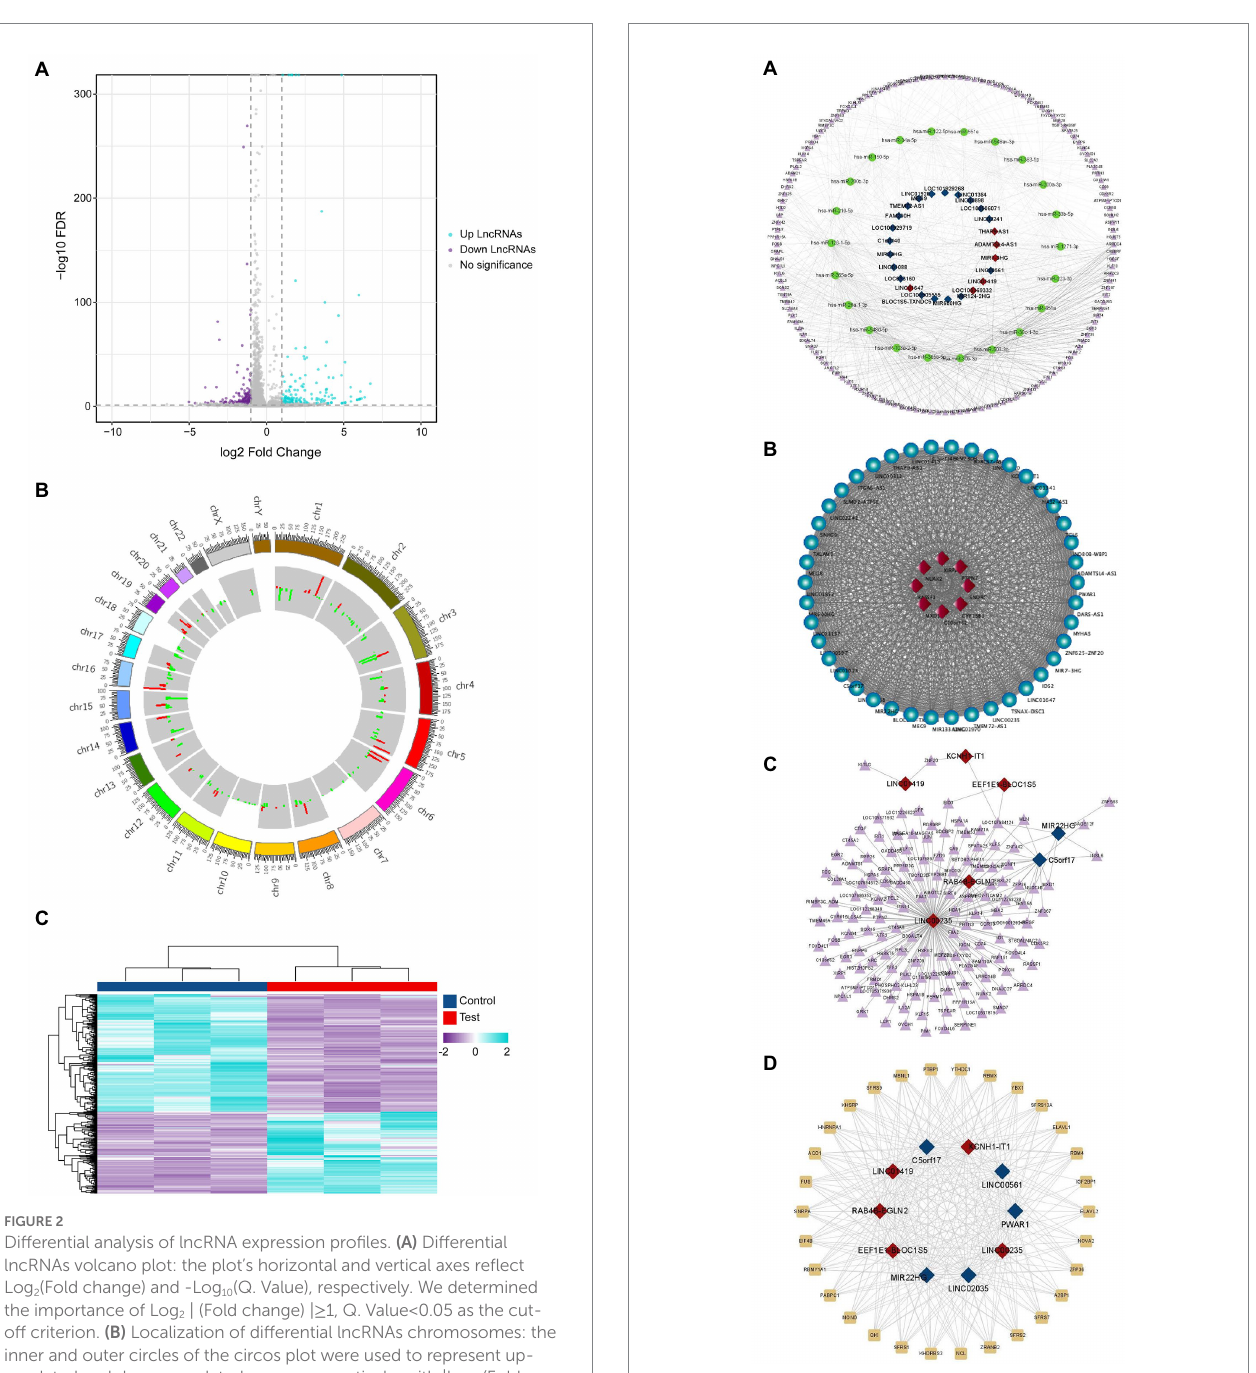
FIGURE 3 Prediction of differential lncRNAs regulation. (A) Differential regulatory network for ceRNAs centered on lncRNAs: This diagram depicts lncRNAs, miRNAs, and mRNAs as squares, circles, and triangles, respectively. Red and dark blue denote the up- and down-regulated lncRNAs, respectively. (B) The co-expression network of lncRNAs and protein-coding genes is constructed in Cytoscape by employing Pearson correlation coefficients. The dots and diamonds indicate lncRNA and mRNA, respectively. (C) Triangles and squares, representing mRNAs and lncRNAs, respectively, depict anticipated up- and down-regulated differential fold top five lncRNAs and targeting relationships of all differential mRNAs, along with all reciprocal pairs predicted to have targeting associations. (D) Network regulation of interactions between lncRNAs and RNA-binding proteins: all potential target proteins of the top five predicted up- and down- regulated differential fold lncRNAs, and all predicted pairs of interactions with targeting relationships, with rectangular and square nodes representing mRNA and lncRNA,